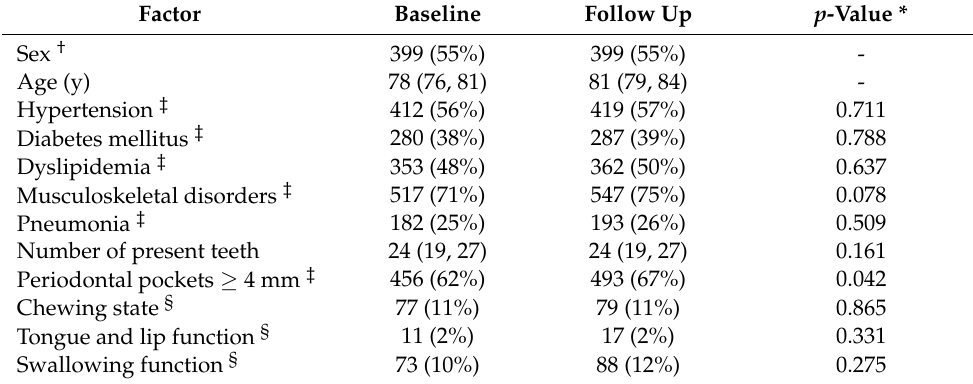
Table 1. Participants’ characteristics ( n =